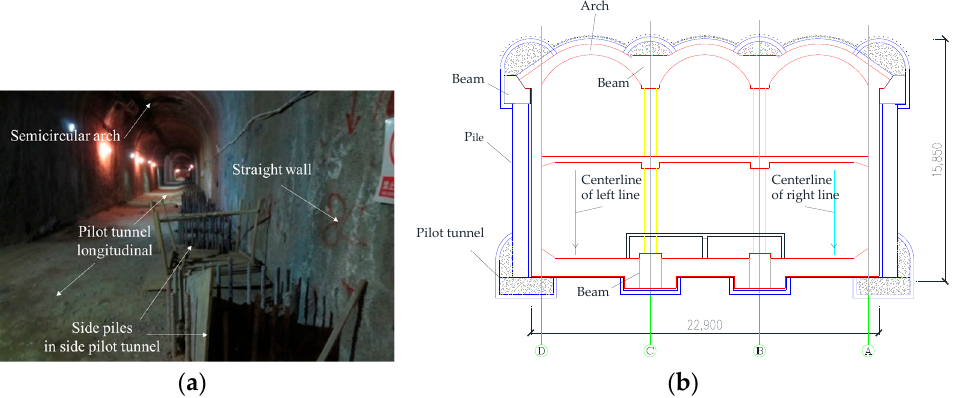
Figure 1. Daguanying station: ( a ) pilot tunnel at the construction site and ( b ) structural section (unit: mm).